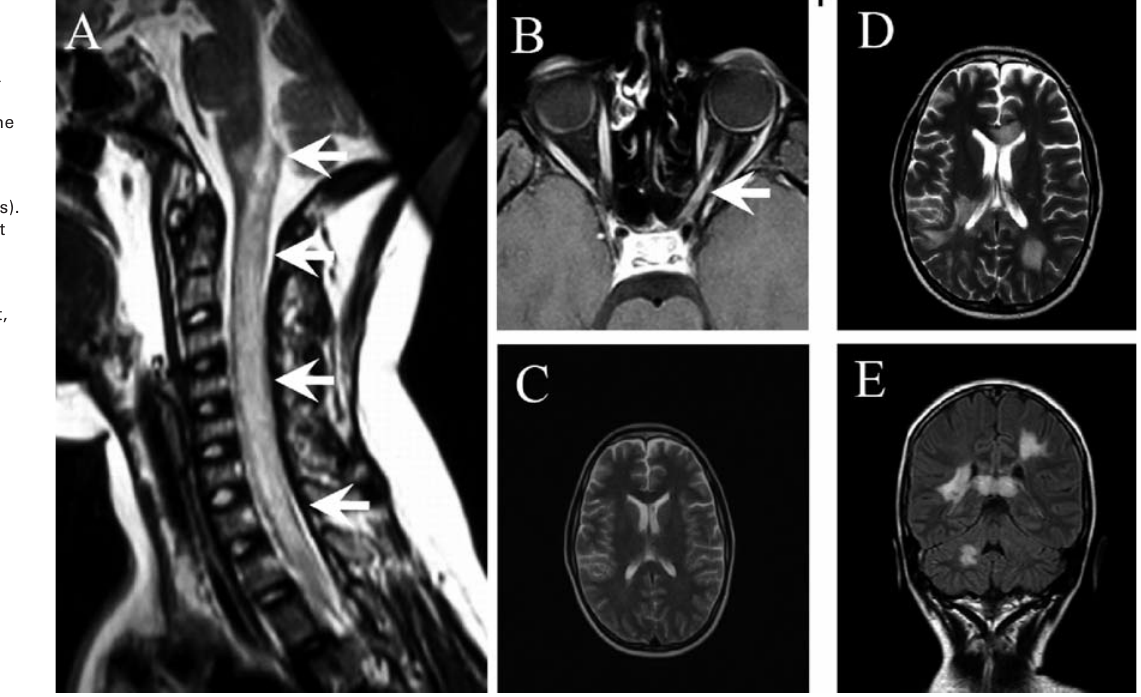
Figure 2 MRI findings in a patient with NMO. (A) Longitudinal ex- tensive spinal cord lesion starting on the medulla oblongata and extending over >8 vertebral seg- ments (white arrows). (B) Lesion of the left optic nerve (optic neuritis, white arrow). (C) At disease onset, brain MRI is often normal. (D and E) 5 years after disease onset, brain lesions are detectable.